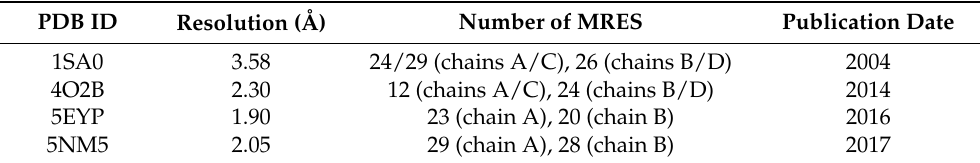
Table 1. Template comparison for α - β tubulin.